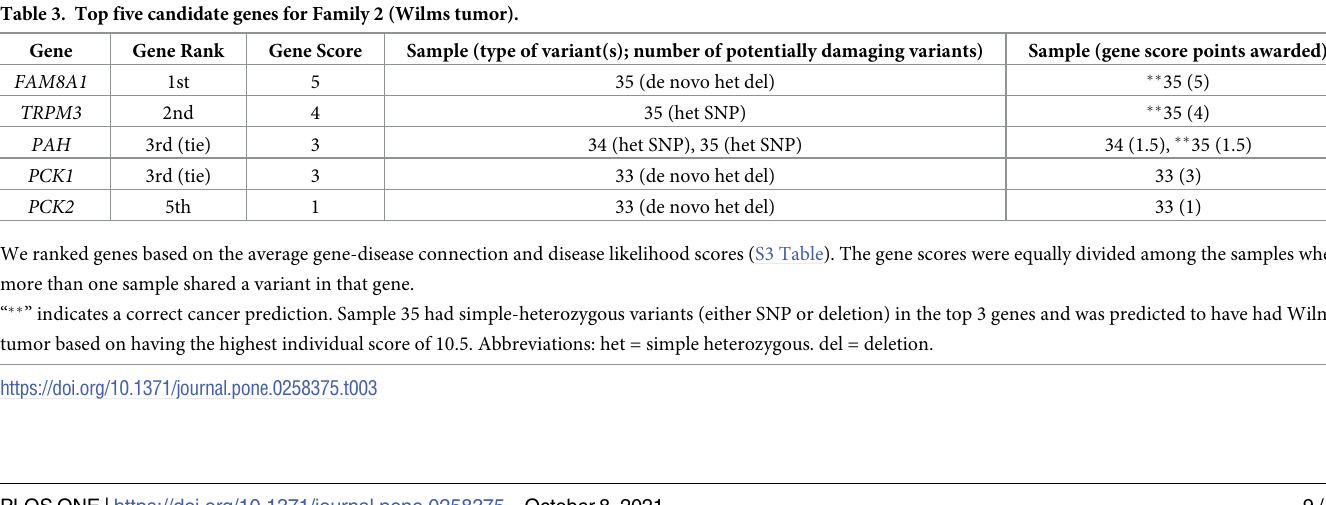
Table 3. Top five candidate genes for Family 2 (Wilms tumor). Gene